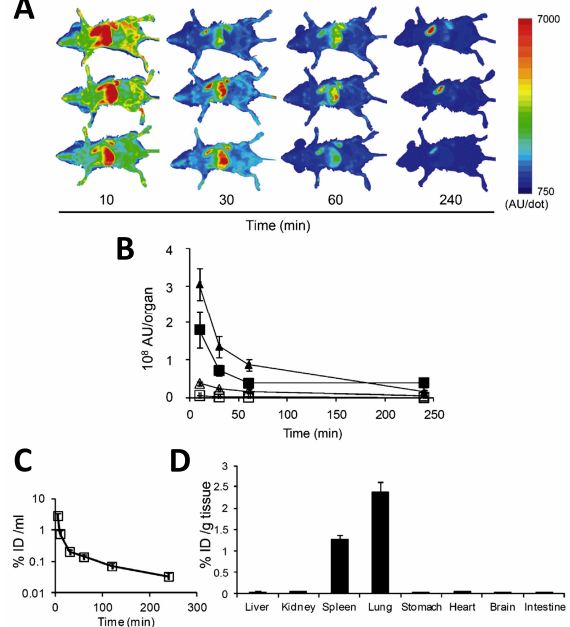
Figure 5. Tissue distribution of exosomes after intravenous administration in mice. ( A ) Tissue distribution of exosomes derived from luciferase expressing B16-BL6 melanoma cells visualized in vivo at different times after intravenous injection in mice. Exosomes were visualized by measuring bioluminescence emission by luciferase after injection of its substrate coelenterazine. The intensity in light emission is represented in pseudocolor; ( B ) Intensity of light emission by luciferase-expressing exosomes measured in arbitrary units in the liver (closed triangle), lung (closed square), kidney (open square) and spleen (open triangle) at different after intravenous injection; ( C ) Time course of luciferase activity in the serum measured as the percent of injected dose per mL (%ID/mL); ( D ) Exosome concentration measured in different organs as the percent of injected dose per gram of tissue four hours after the intravenous injection. Reproduced from [160] with permission from the